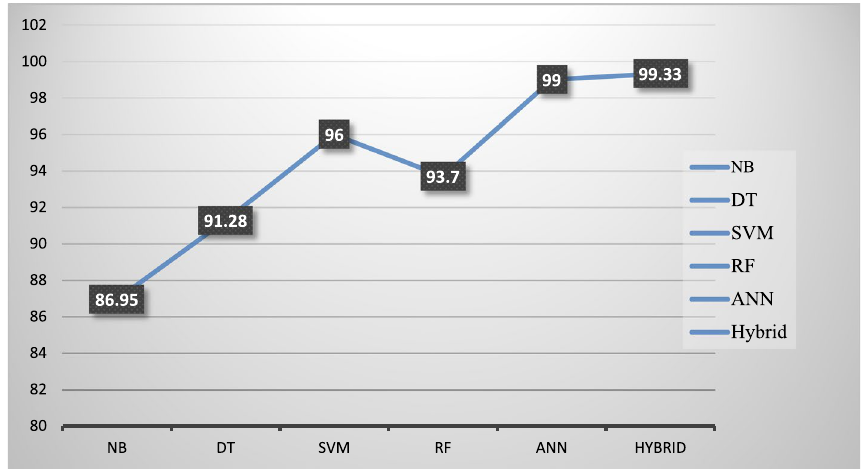
Fig. 7 Performance distribution of the techniques in the test set